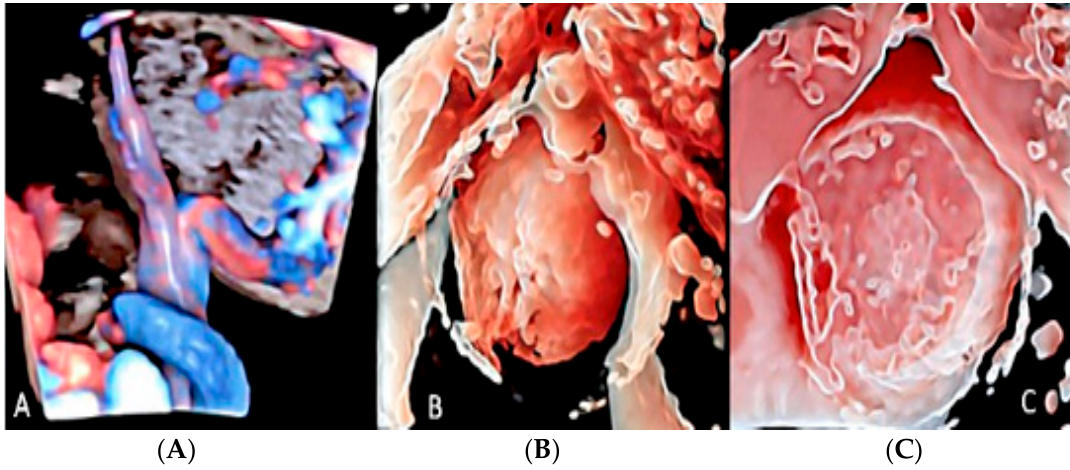
Figure 13. Chorioangioma. Pregnancy at 20 and 26 week’s gestation. Two-dimensional color Dop- pler ( A ), three-dimensional ultrasound with HD-live™ surface rendering ( B ) and with Silhouette™ effect ( C ). Chorioangioma arises from the fetal surface of the placenta, where vessels’ cords diverge before joining the placenta.